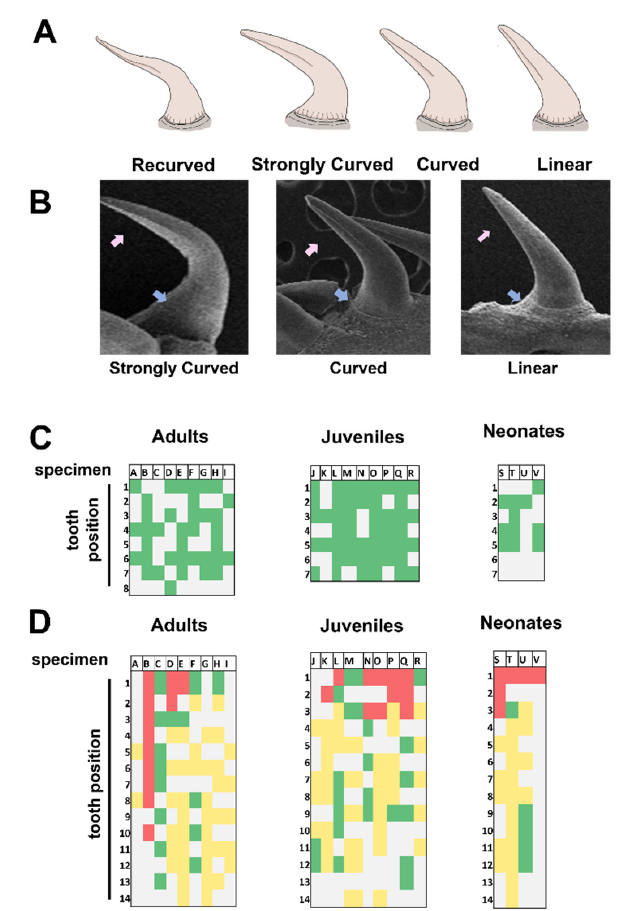
Figure 5. Galvarinus ch. chilensis presents three types of teeth the dentary and maxilla. ( A ) Representative illustration of tooth types in maxilla and dentary bones usually observed in snakes. ( B ) Representative images of strongly curved (adult—MZUC 11,658), curved (adult—MZUC 45,318), and linear (adult—MZUC 4567) teeth. ( C ) Distribution map of type of teeth in the maxilla and ( D ) dentary bones in adults (N = 9), juveniles (N = 9), and neonates (N = 4). Letters in boxes (A–V) indi ‐ cate the MZUC specimens used. Detailed information and voucher numbers are shown in Supple ‐ mentary Table S1. Colors represent the types of teeth as follows: green: strongly curved tooth; yel ‐ low: linear tooth; red: curved tooth; gray: not determined. Arrows indicate: pink = ridges and blue = parallel ridges.